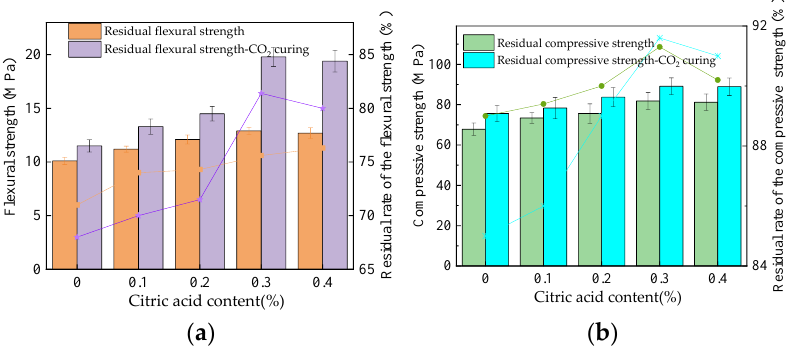
Figure 11. The residual strength of the MOS paste after 60 sulfate dry-wet alternations. ( a ) Flexural strength. ( b ) Compressive strength.